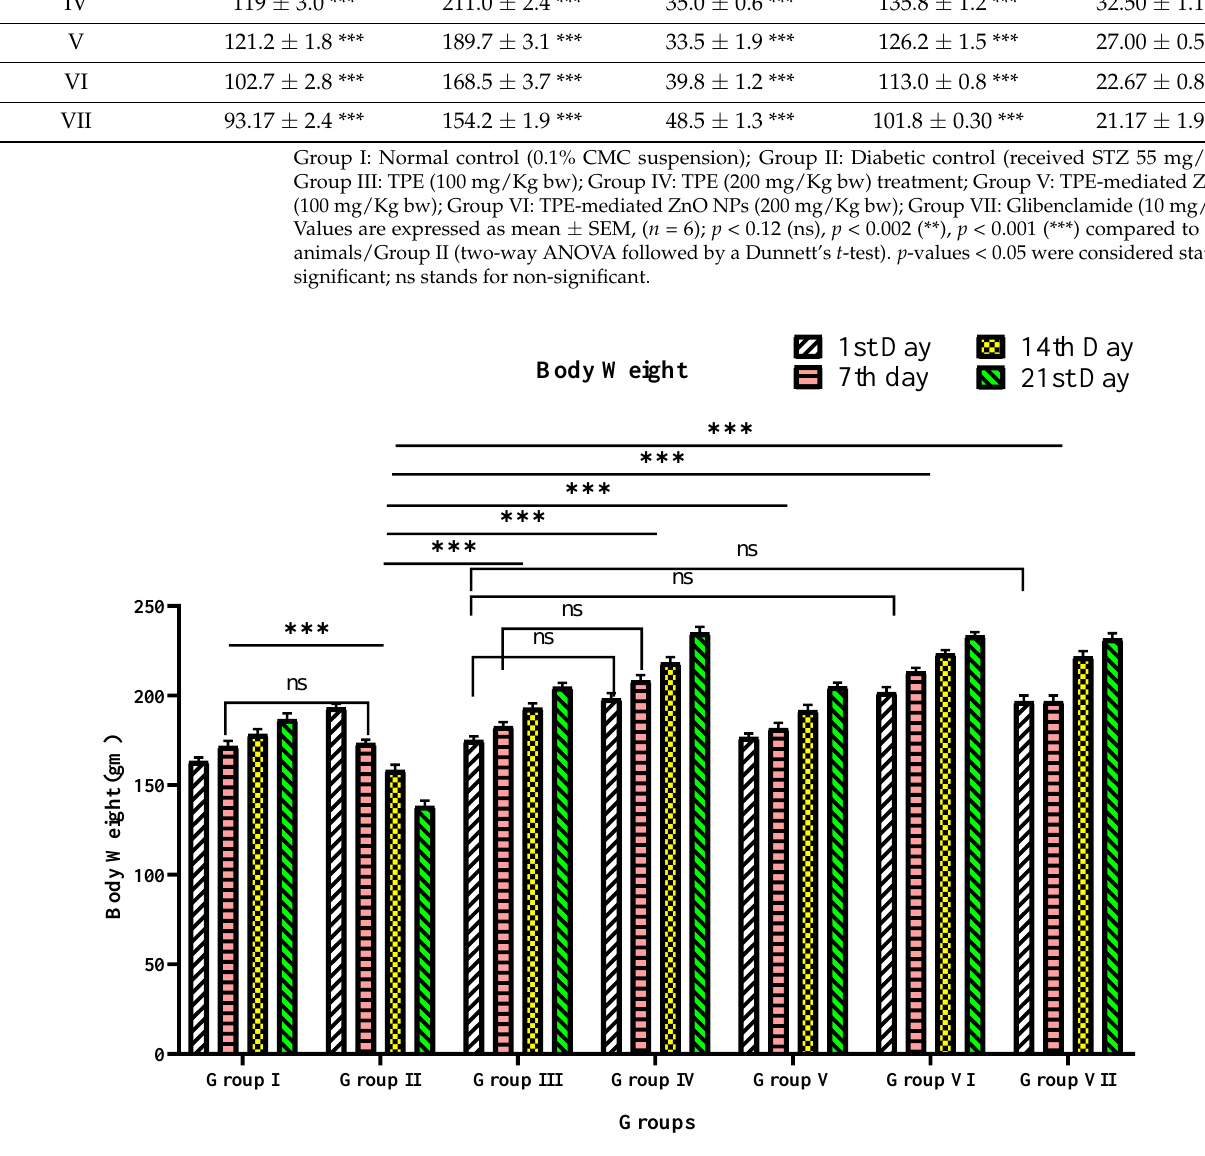
Figure 7. Graphical representation of TPE and TPE-ZnO NPs’ effects on body weight (g) in STZ- induced diabetic rats. Group I: Normal control (0.1% CMC suspension); Group II: Diabetic control (received STZ 55 mg/Kg bw); Group III: TPE (100 mg/Kg bw); Group IV: TPE (200 mg/Kg bw) treatment; Group V: TPE-mediated ZnO NPs (100 mg/Kg bw); Group VI: TPE-mediated ZnO NPs (200 mg/Kg bw); Group VII: Glibenclamide (10 mg/Kg bw). Values are expressed as mean ± SEM, ( n = 6); p < 0.12 (ns), p < 0.001 (***) compared to diabetic animals/Group II (two-way ANOVA followed by a Dunnett ’ s t -test). p -values < 0.05 were considered statistically significant; ns stands for non-signifi-